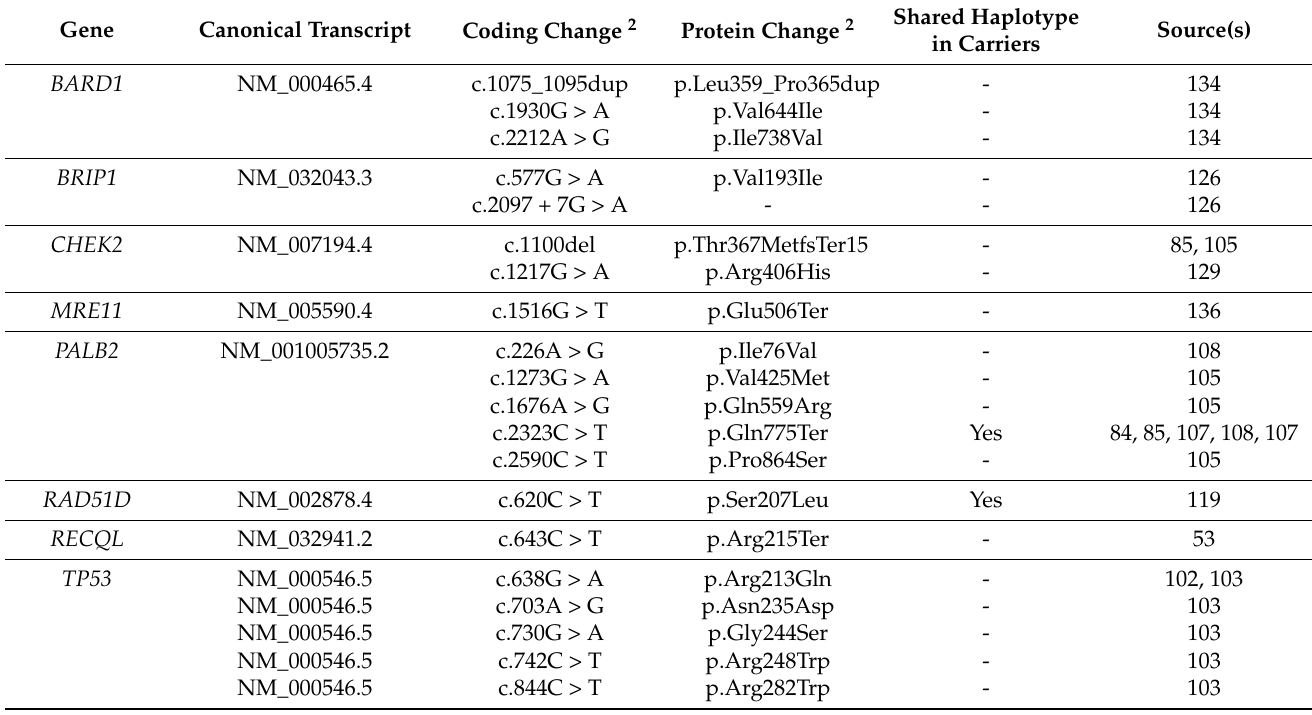
-: Data not available. 1 See Table S3 for more information on variants. 2 All annotated variants are based on the Human Genome Reference GRCh37/hg19 and the HGVS nomenclature